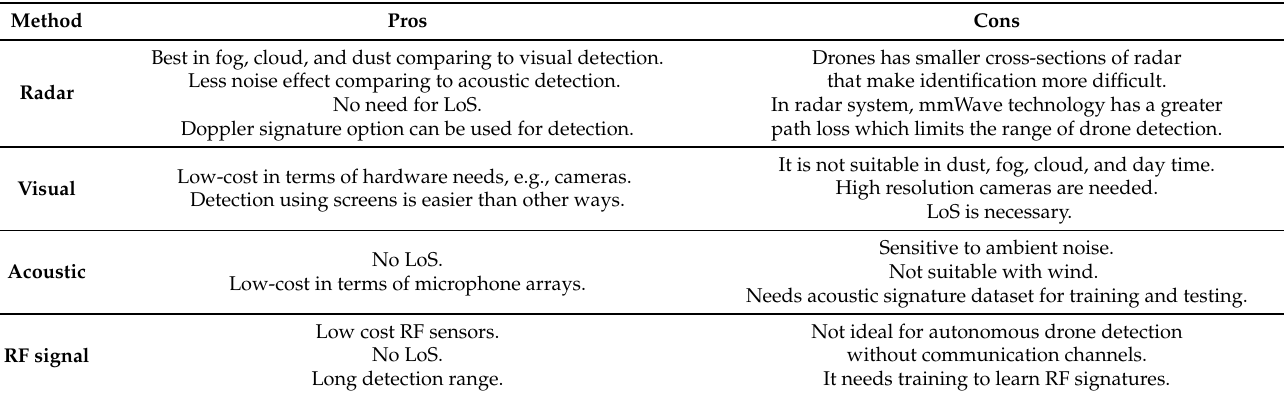
Table 1. Summary of the detection